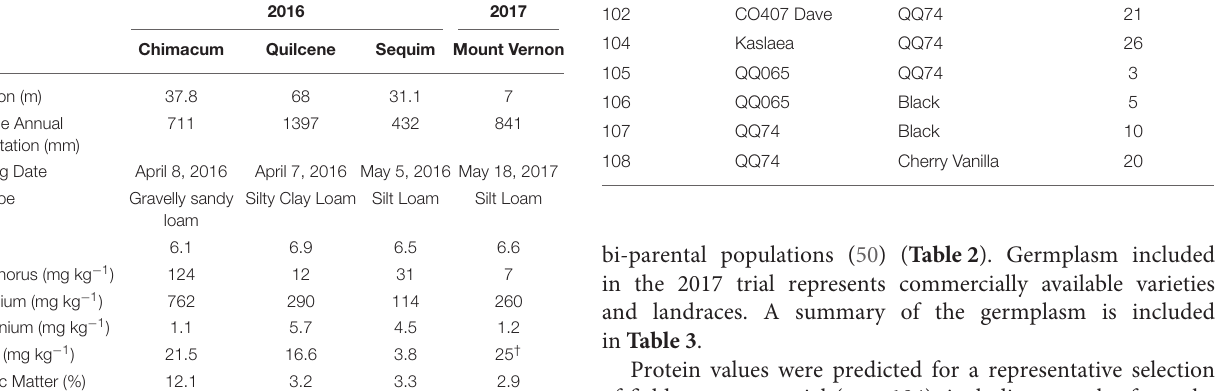
TABLE 2 | Female and pollen parents listed for each bi-parental population, with the number of samples from each population included in the study.